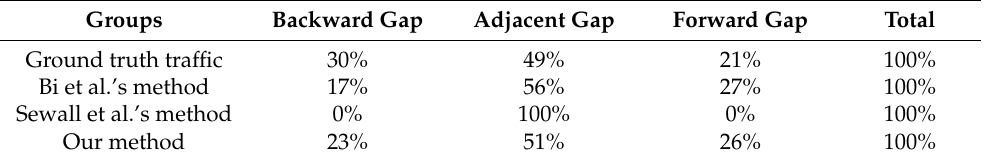
Table 2. Lane-changing decision-making result